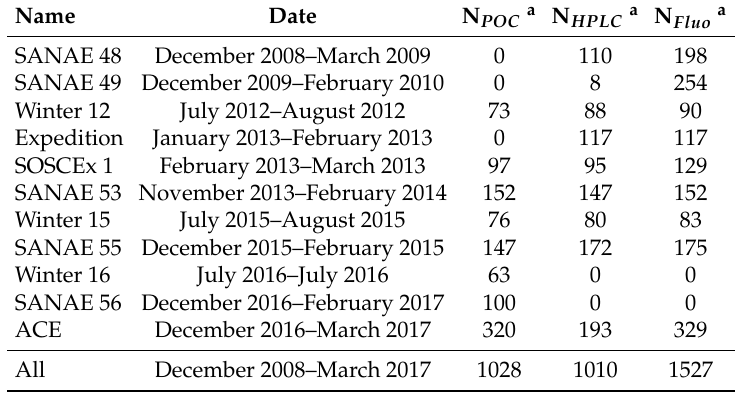
Table 1. Southern Ocean research cruises during which POC, HPLC and fluorometric chlorophyll-a samples were